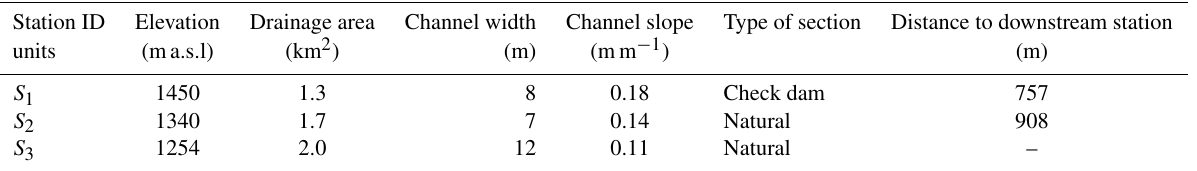
Table 1. Physical features of the three monitoring stations.